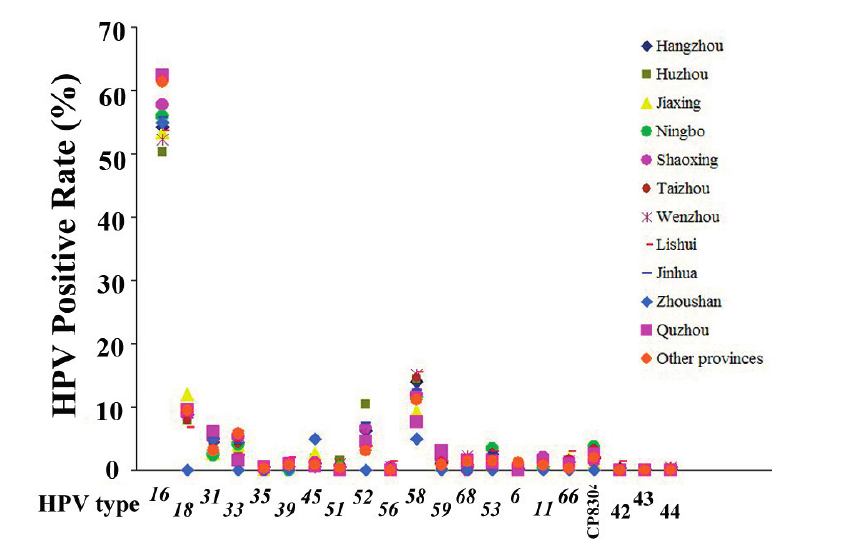
Figure 2. Geographic variation of HPV infection in hospital-based female population in Zhejiang Province. HPV attribution varied substantially among regions in Zhejiang Province, HPV16 predominates the pathogenesis among all regions, followed by HPV58, 18, 52 and other